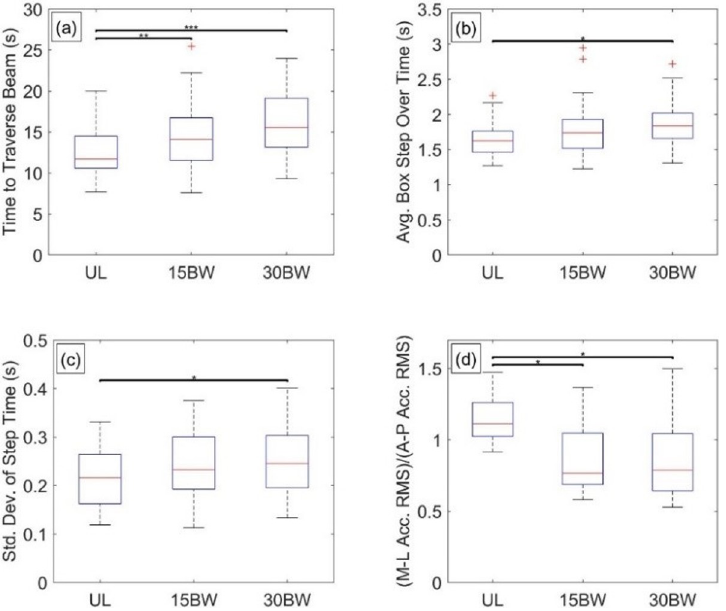
Fig 10. Balance beam statistical results. Boxplots depicting the results from the Tukey post hoc analysis of balance beam metrics for a) time to traverse the beam, b) average box step over time, c) standard deviation of step time, and d) ratio of root-mean squared (RMS) medial-lateral (M-L) acceleration to anterior-posterior (A-P) acceleration. The bars denote significant differences between loading conditions at a significance level α = 0.05 � , 0.01 �� , 0.001 ���